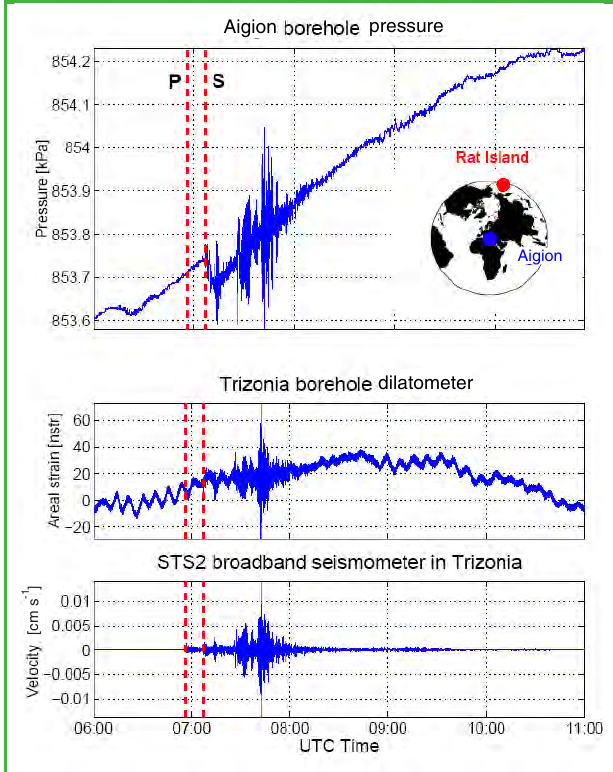
Figure 3. Pressure gauge readings in the 1000-m-deep AIG10 well that intersects the active Aigion fault at 760 m. Response to the S-waves generated by the Mw7.9 17 November 2003 Rat Island earthquake (Aleutian Isles). Seismic waves are recorded because of S-P conversion (Doan and Cornet, 2007). We also present data acquired 10 km north of the site. The borehole dilatometer and the broadband seismometer record the seismic waves, but do not display any anomaly, indicating that the pressure drop is induced in the vicinity of the AIG10 borehole.